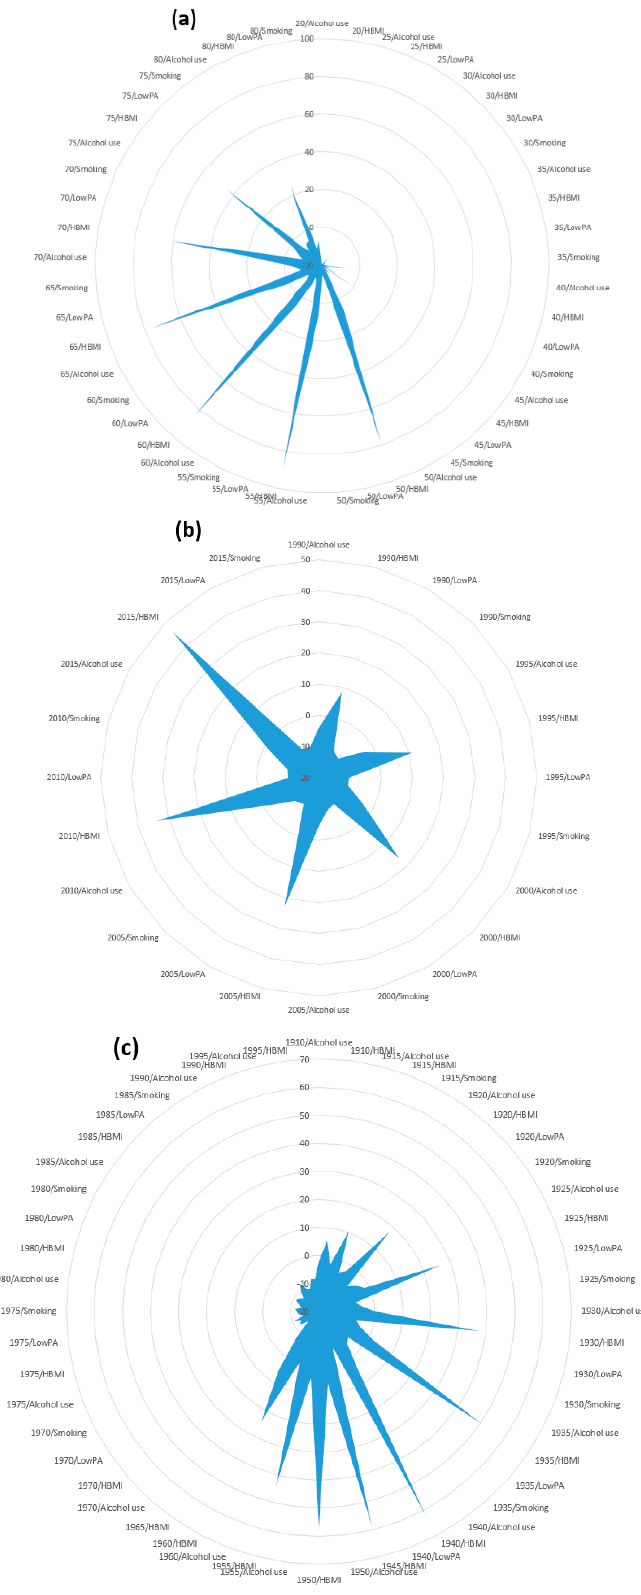
Figure 3. Random e ff ects of ( a ) age, ( b ) period, and ( c ) cohort interaction with di ff erent risk factors on Figure 3. Random effects of (a) age, (b) period, and (c) cohort interaction with different risk factors on DALYs using hierarchical APC DALYs using hierarchical APC model.